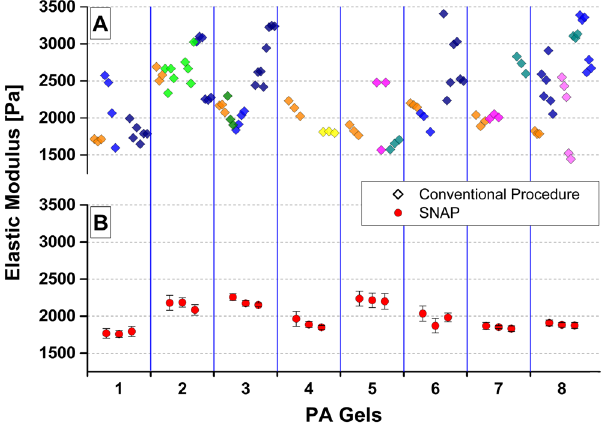
Figure 1. Comparison of mechanical properties of polyacrylamide gels measured with conventional procedure and with SNAP. ( A ) Elastic moduli of eight gels prepared centrally in Bremen and measured from the different participating labs. Each diamond marker indicates the mean value of the elastic modulus extracted from each force map; data were acquired and analysed using the conventional AFM procedure. Different marker colours stand for different AFMs from several manufacturers: JPK (NanoWizard III), Bruker (Catalyst, Nanoscope and Multimode), Park System (XE120) and Asylum (MFP3D). ( B ) Same eight polyacrylamide gels were measured in Bremen and elastic moduli were evaluated applying the standardized nanomechanical AFM procedure (SNAP). Each circle marker indicates the mean value of the elastic moduli extracted from a force map (made of 100 force curves). On each gel three force maps were recorded. Bars represent standard